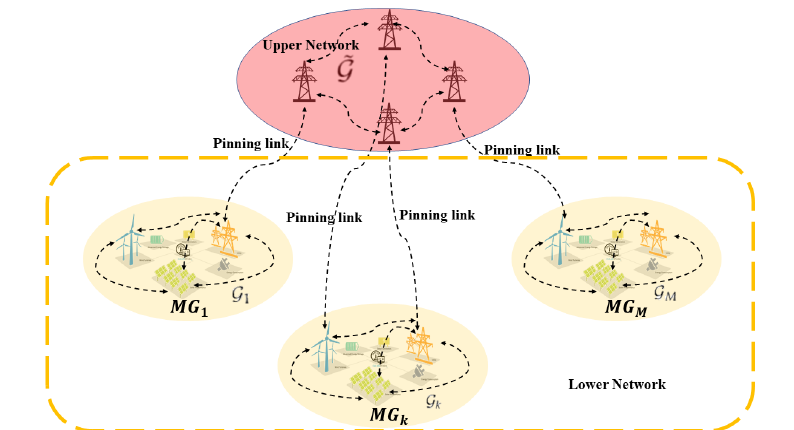
Figure 1. Microgrid (MG) cluster supported by a double-layer communication network: the upper network is highlighted in red and the lower network is highlighted in